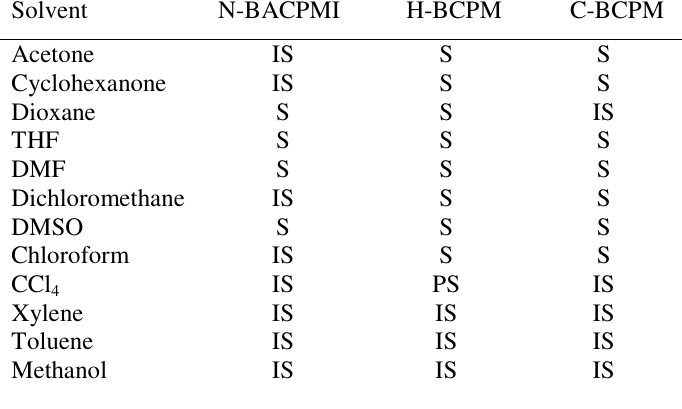
and Non-polar Solvents at